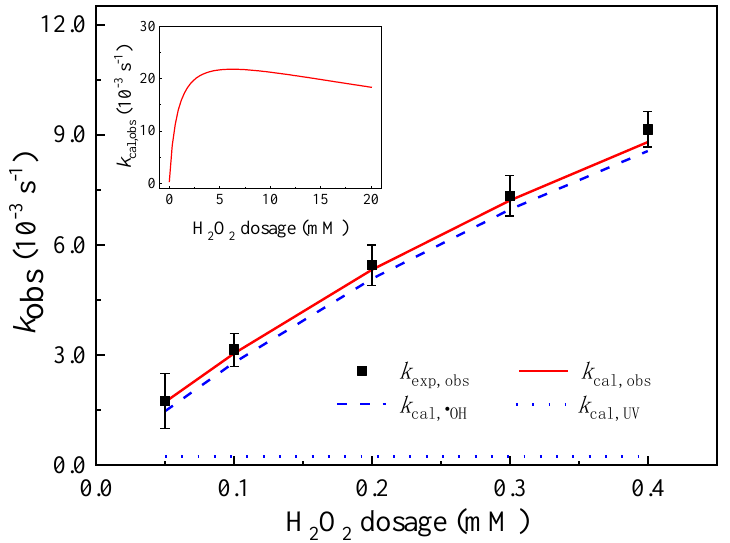
Figure 6. Impacts of H 2 O 2 dosages on the pseudo first-order constants of MTZ ( k obs ). ([MTZ] 0 = 10 μM, pH = 3.00, and I 0 = 7.50 × 10 − 6 Einstein L − 1 s − 1 , l = 0.935 cm.)